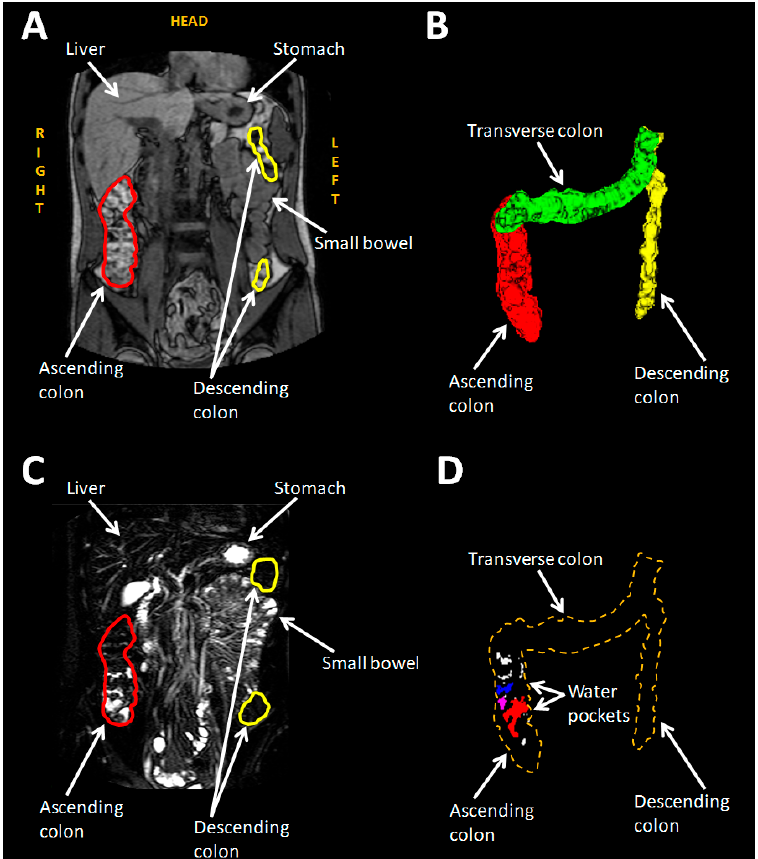
Figure 4. ( A ) MRI bowel image. ( B ) 3D reconstruction of the bowel. Red, green, and yellow stand for ascending, transverse and descending colon respectively. ( C ) Highly T2 weighted image with the same angle of ( A ). Unbound liquid appears white whereas bound and less mobile liquid seem darker. ( D ) Unbound liquid of the colon. Reproduced from [43], American Chemical Society, 2017 with permission.